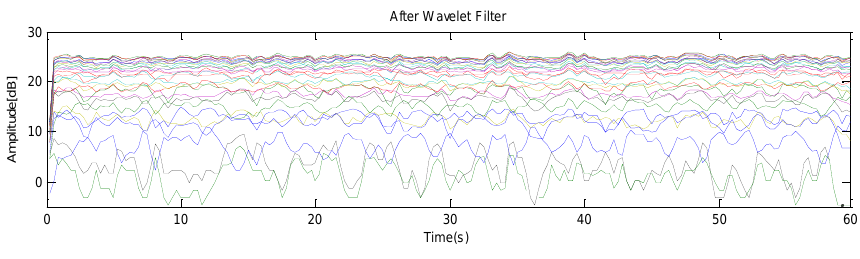
Figure 16. Filtered CFR for abnormal breathing.